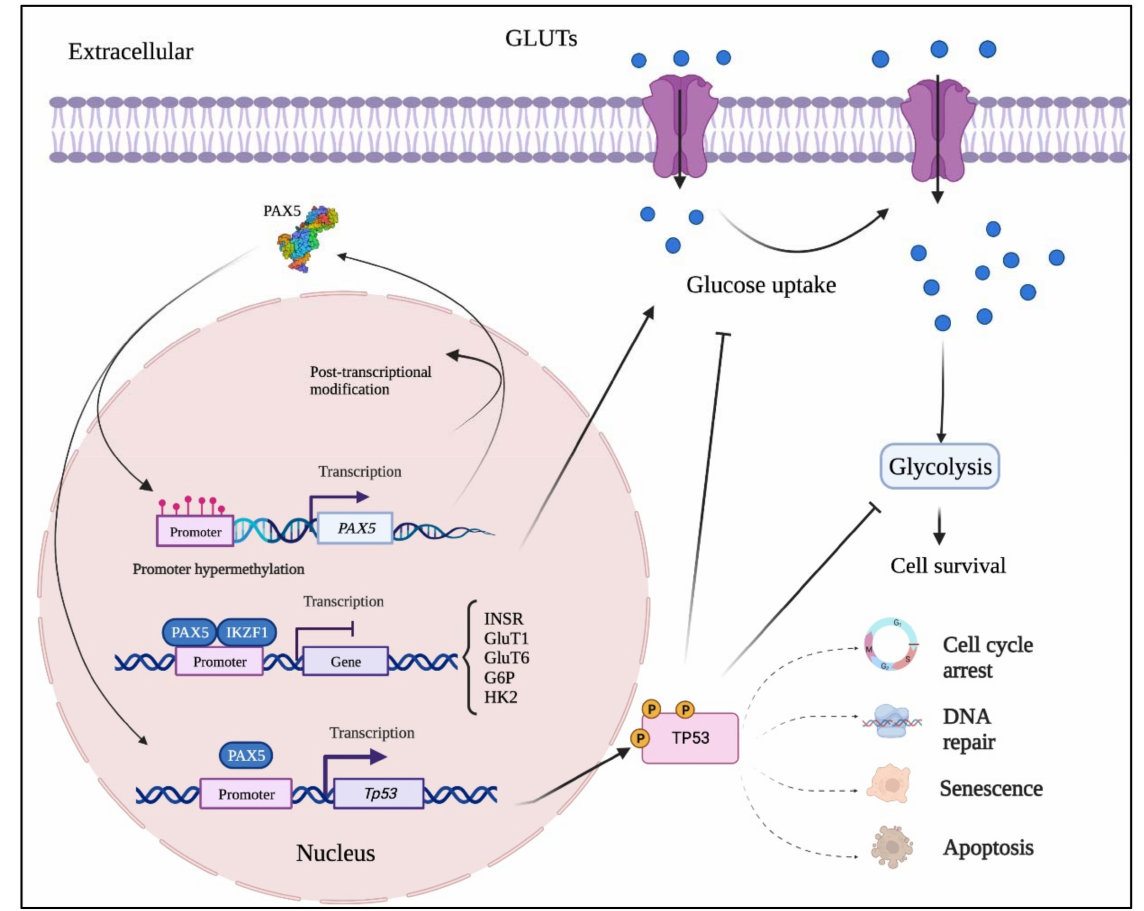
Figure 4. Mutation-independent mechanisms leading to aberrant PAX5 signaling and cell